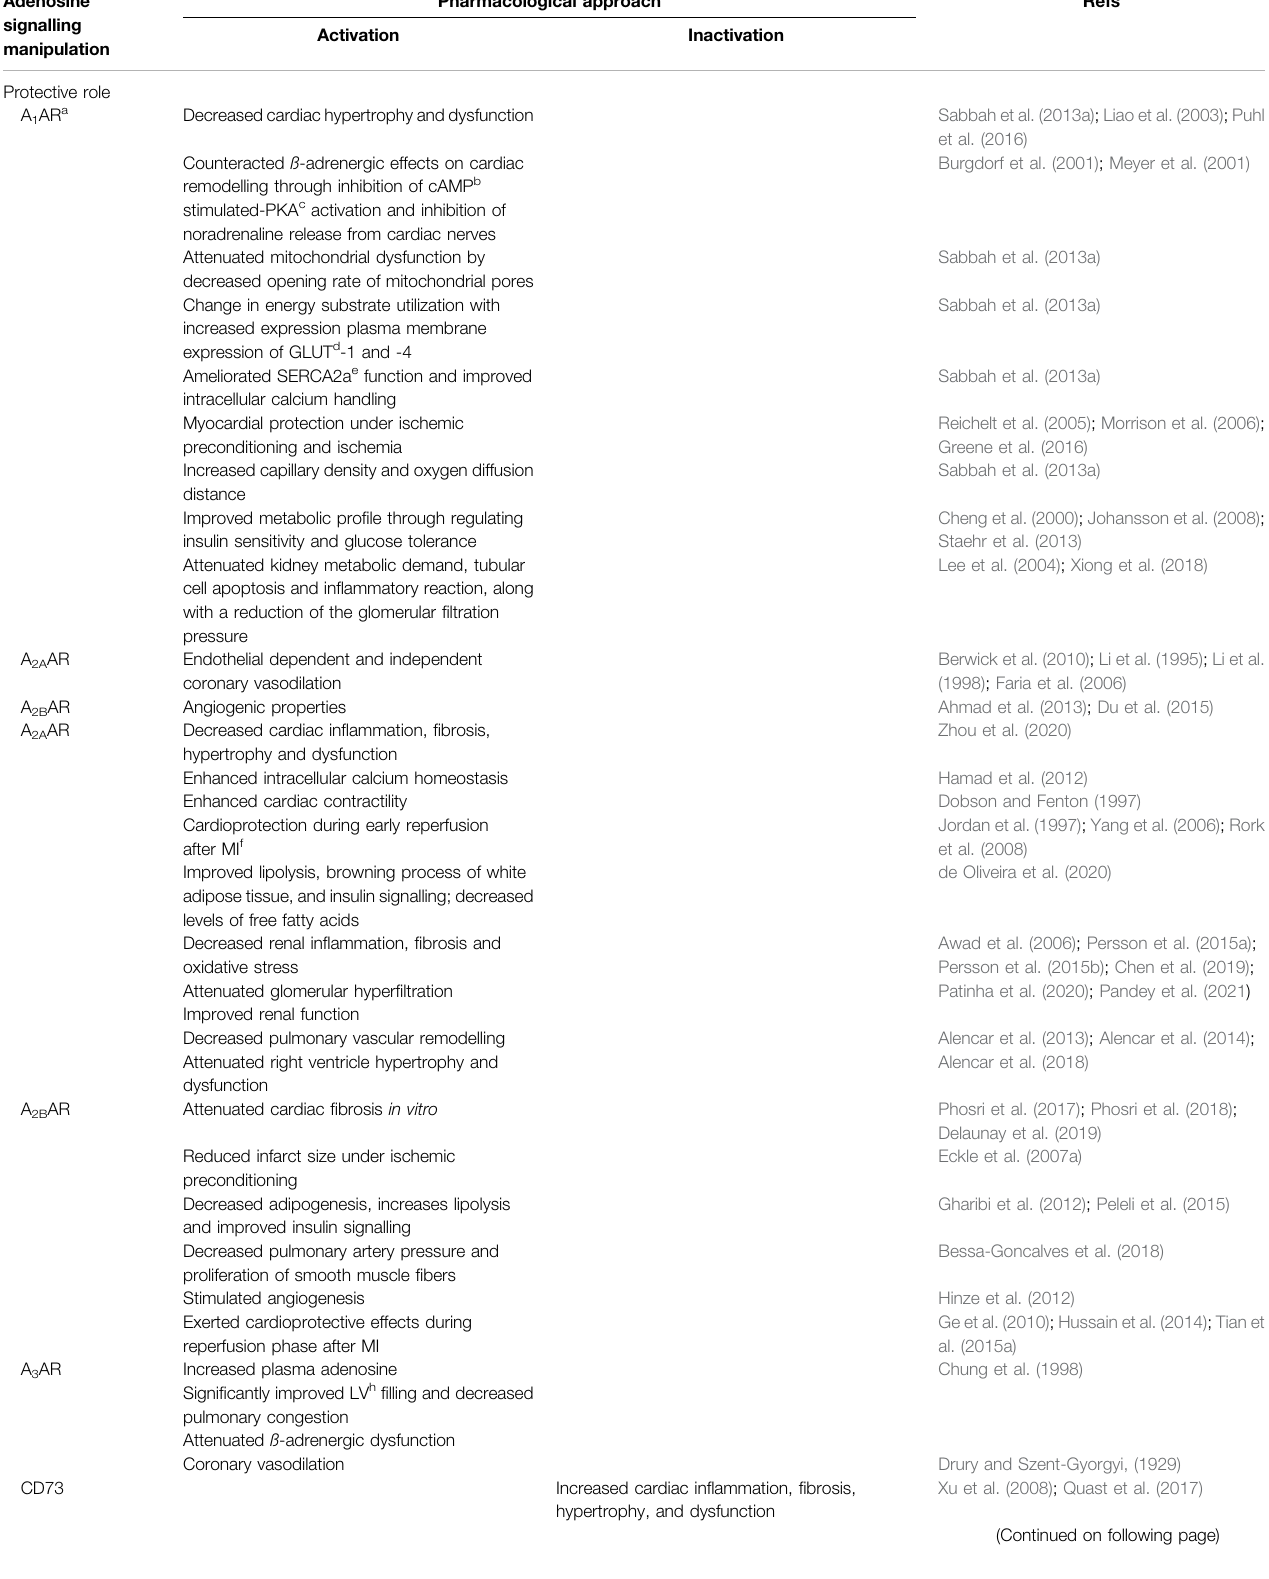
TABLE 3 | Pros and cons of targeting adenosine receptors, enzymes and metabolism in molecular pathways underlying heart failure with preserved ejection fraction and cardioprotection. Adenosine